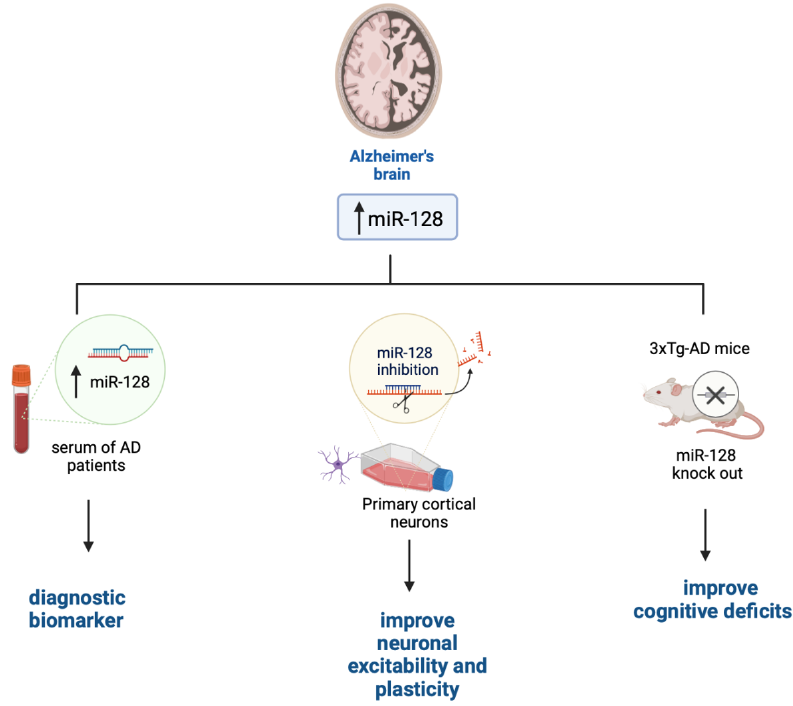
Figure 1. The role of miR-128 in AD. Figure created with BioRender.com accessed on 1 March 2023.